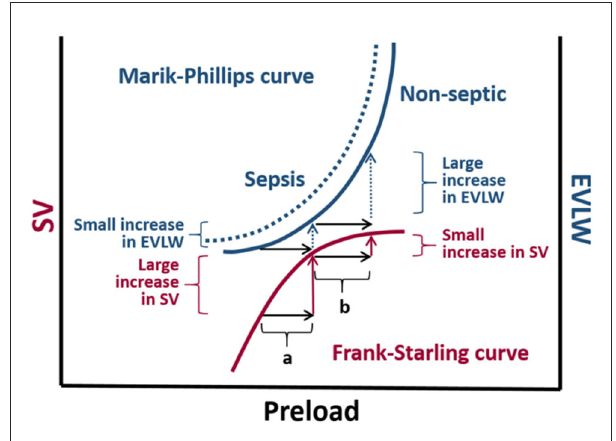
FIGURE1 The Marik-Phillips and Frank-Starling curves correlating changes in extra vascular lung water (EVLW) and stroke volume (SV) with preload. For cardiac function correlating to the ascending limb of the Frank-Starling curve, an increase in preload induced by a fluid challenge (a) does not substantially increase EVLW. If a fluid challenge is administered to individuals whose heart is operating on the flat portion of the Frank-Starling curve, the increase in preload (b) may result in a large increase in EVLW. Due to endothelial glycocalyx damage associated with sepsis, larger increases in EVLW can be expected in septic individuals (dashed curve) (9,